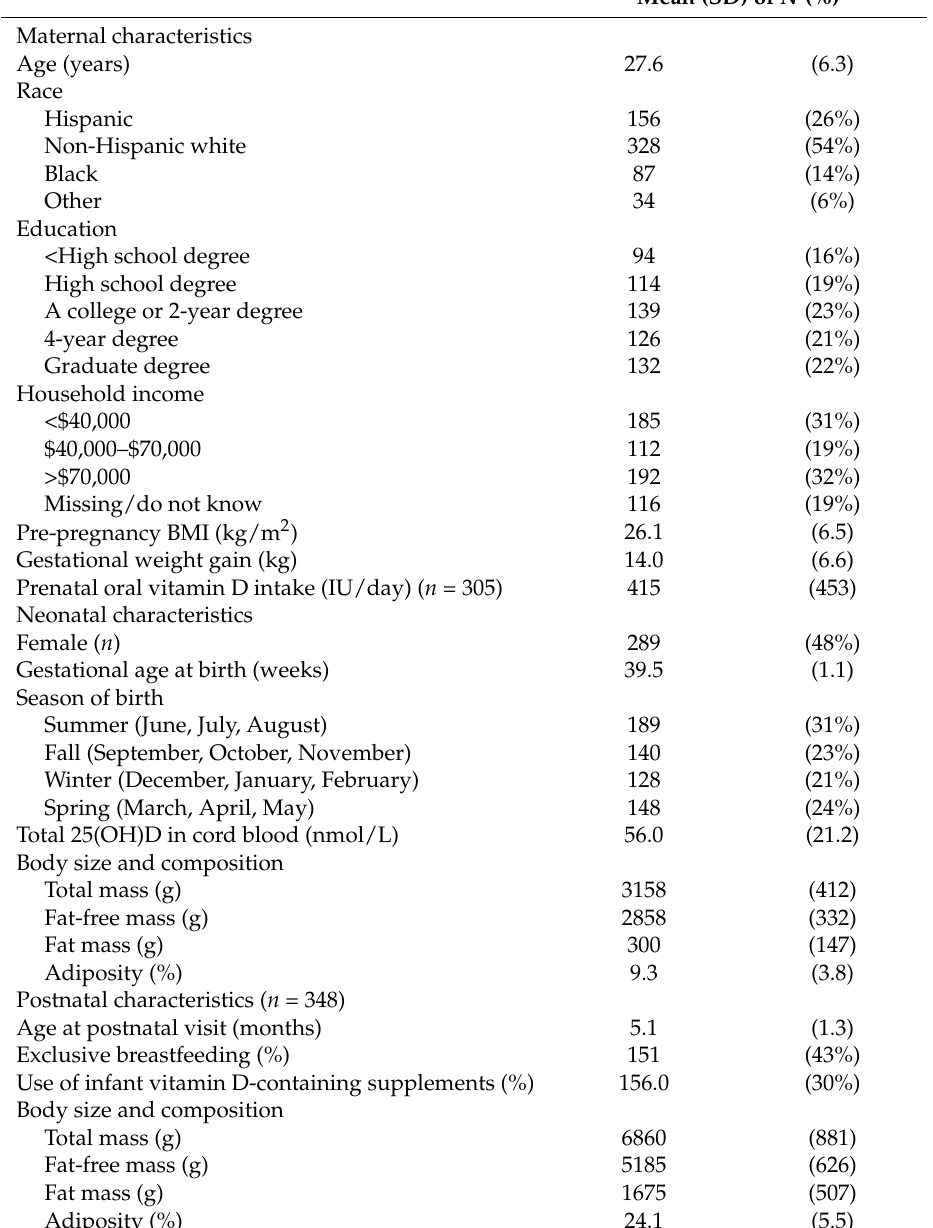
Table 1. Sample characteristics